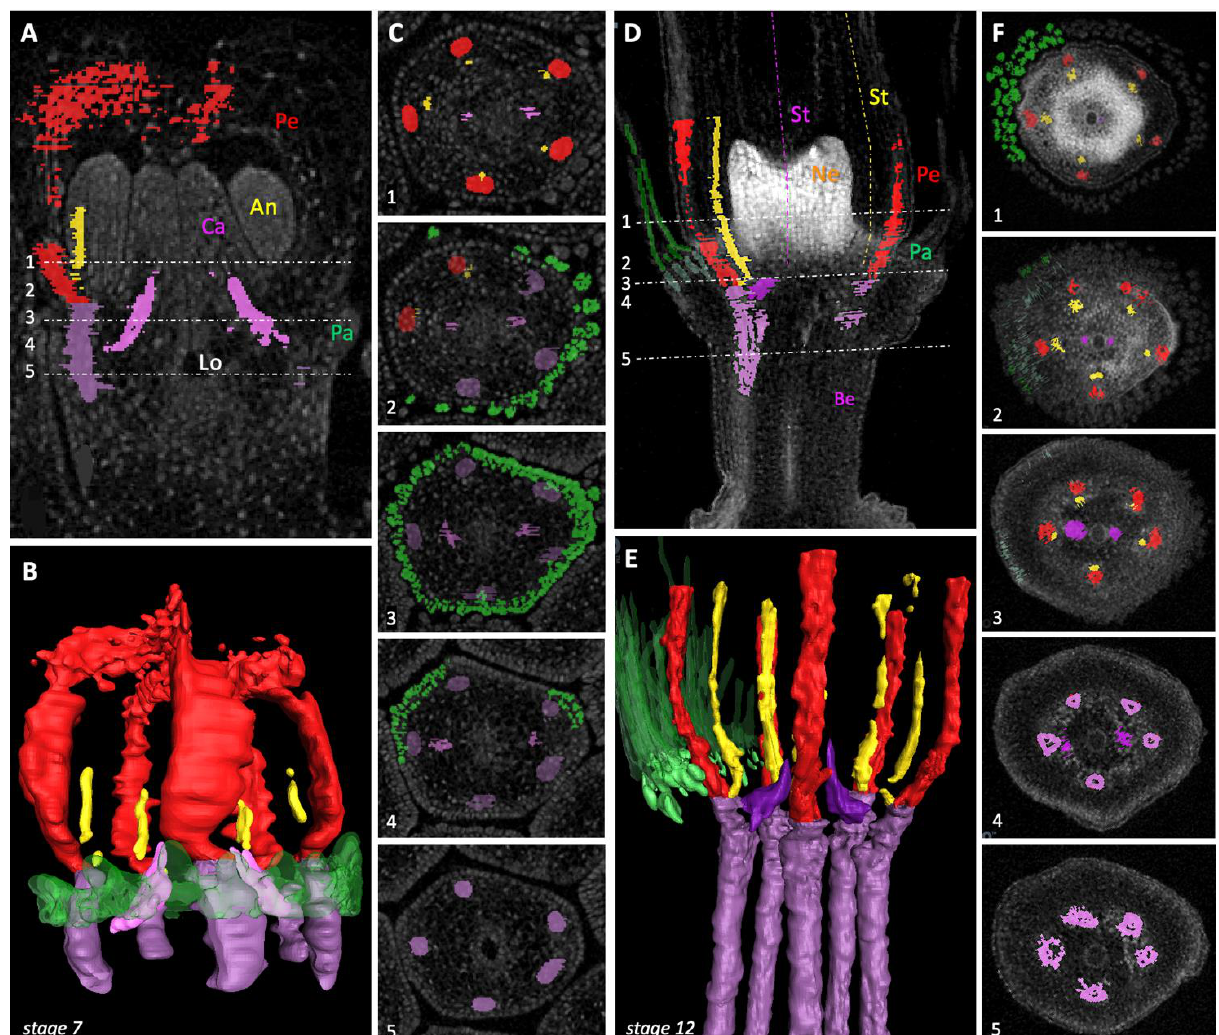
Figure 5. Micro-computed tomography scanning analysis of the floral vasculature and pappus development in dandelion. Young floret ( stage 7 ; Table 1; ( A – C )) and floret at anthesis ( stage 12 ; ( D – F )) presented in a vertical section ( A , D ), 3D-model (( B , E ); Supplementary Videos V1, V2), and five horizontal sections ( C , E ) of which the cutting edges are indicated by num- bers and white dashed lines in the vertical sections. Pa (green) = pappus; Pe (red) = petal bundle; An / St (yellow) = anther / stamen bundle; Ca / St (pink 1) = carpel / style bundle; (pink 2) = main bundle; Lo = locule; Be = beak; Ne = nectaries. ( A ) Segmentation of one of the five main bundles, its split to one of the carpels and bifurcation to a petal and an anther, and the bundle to the second carpel. ( B ) 3D-model showing the entire vasculature of the floret, and the pappus. Main bundles of the pappus are absent. The movie (V1) also visualizes the bifurcation of one of the petal bundles. ( C ) Exact position of vascular bundles, their splits, and context to the developing pappus, confirming that the pappus initiates at the height where two main bundles split to the carpels (section 4). ( D ) In mature florets, capillaries (light green) to the pappus parts (dark green) are present in the upper part of the pappus ring, and the split of bundles to the carpels and petal/anthers occur in a more compressed region (sections 3 and 4). Additionally, nectaries (abundant white cells) and the beak are clearly visible. ( E ) 3D-model showing the capillaries (solid green) to the pappus parts (green-transparent). Main bundles are much enlarged as compared to the young floret and bundles or capillaries to the nectaries are absent. The nectaries are also shown in the movie (V2). ( F ) The sections show that the capillaries to the pappus parts become visible at the height where the main bundles split to the petals and anthers (section 3). A high-resolution scan showed that they actually branch off earlier, at the bifurcation of the carpels (Supplementary Figure S3). © Monique Welten. common ovarian vasculatures was confirmed for dandelion, with encircled numbers in- dicating the main bundles that each split to supply a petal and an anther, and the solid lines indicating the two bundles that supply the carpels, the latter including the movement of one of the two bundles to a more central position (Figure 6B). Additional visualization of this ovarian vasculature in a young ( stage 7 ) and older ( stage 12 ) floret of dandelion is